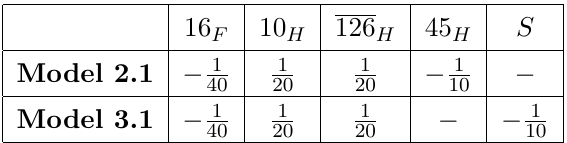
Table 6 . Charges of the fermionic and scalar (cid:12)elds under a PQ-protecting discrete Z 40 symmetry for Models 2.1 and 3.1. The lowest dimensional PQ violating operators allowed by these symmetries are 45 10 for Model 2.1 and S 10 for Model H